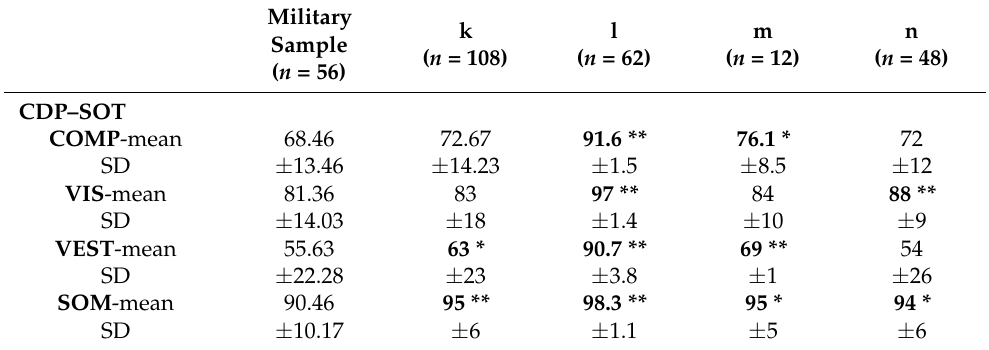
Table 3. Comparison of the performance-based vestibular function by the CDP–SOT following a TBI.